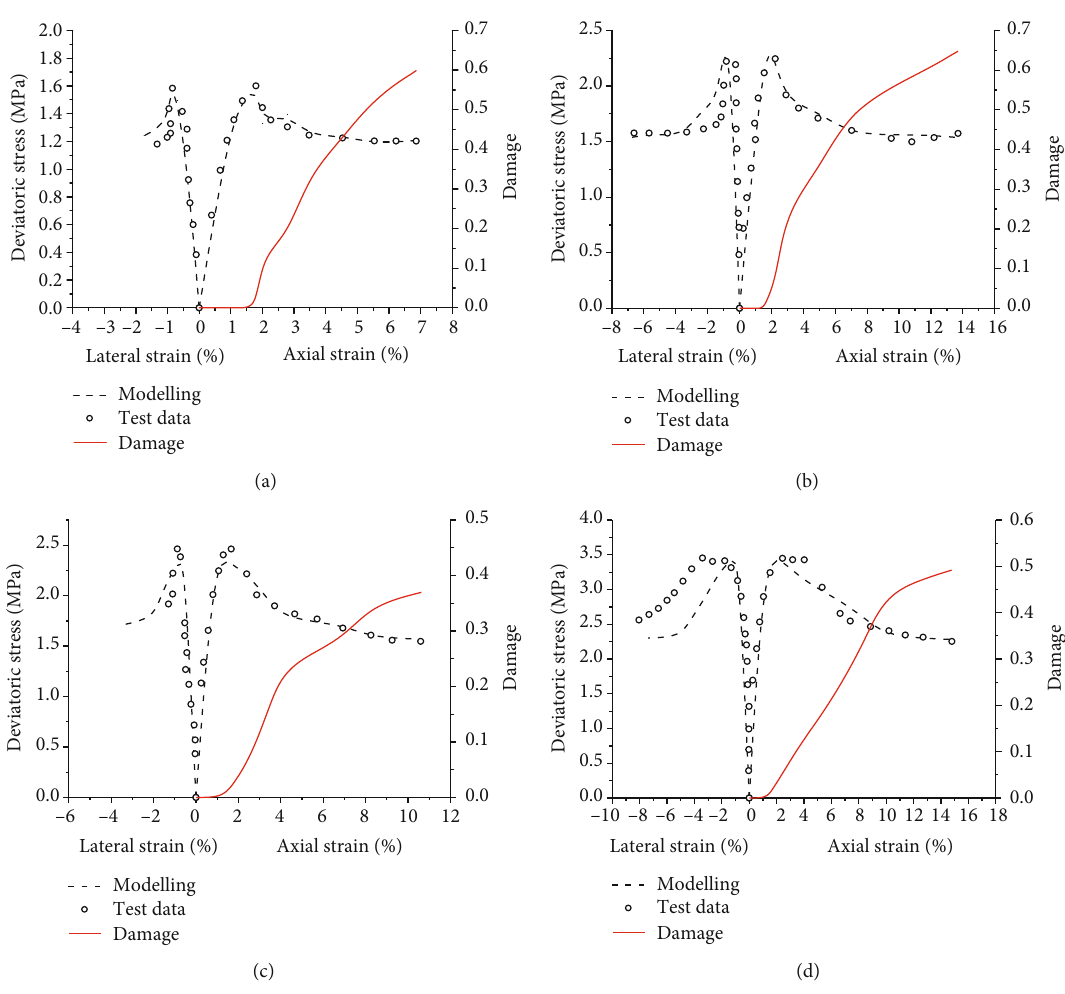
Figure 10: Comparison of the stress-strain curves under di ff erent con fi ning pressures between the numerical analysis and experiments: (a) con fi ning pressure 0.89MPa, (b) con fi ning pressure2.5 MPa, (b) con fi ning pressure 2.85 MPa, and (d) con fi ning pressure